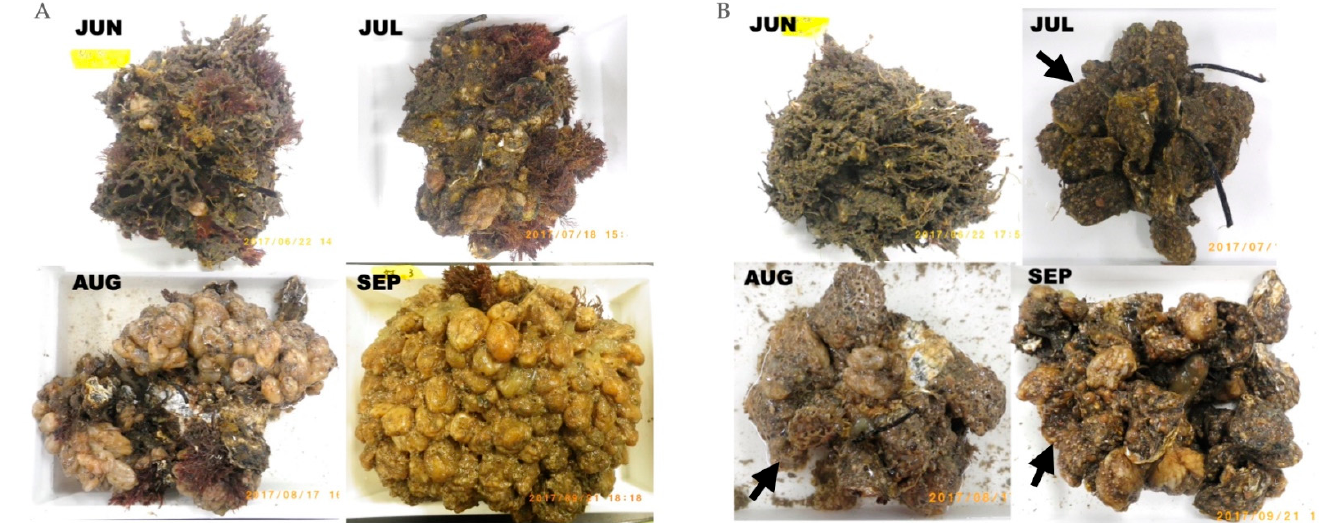
Figure 3. Photographs of oyster collectors between the ( A ) control group and ( B ) A. minuta group were taken for each monthly sampling. Black arrows indicate A. minuta -covered surfaces on oyster collectors which were dominantly observed from June to September.